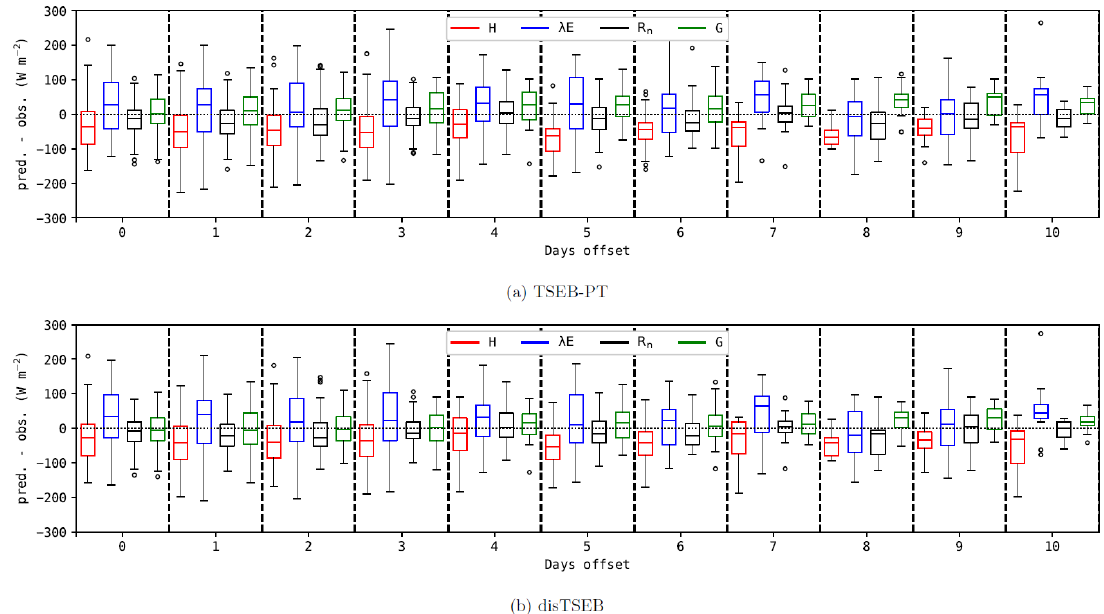
Figure 2. Error (modelled–measured) distribution of fluxes modelled with TSEB-PT and disTSEB models using sharpened T rad depending on offset days between a Sentinel-3 T rad image and the fine-scale Sentinel-2 multispectral image. Error computed for all sites together. Table 8. Landscape feature size dependence of errors for low and high resolution TSEB-PT modelled fluxes using Decision Trees sharpened temperatures. N, number of valid cases; Obs.; mean of observed values (W m − 2 ); bias, mean difference between predicted and observed (W m − 2 ); MAE, Mean Absolute Error (W m − 2 ), RMSE, Root Mean Square Error (W m − 2 ); rRMSE, Relative RMSE (–); r, Pearson correlation coefficient